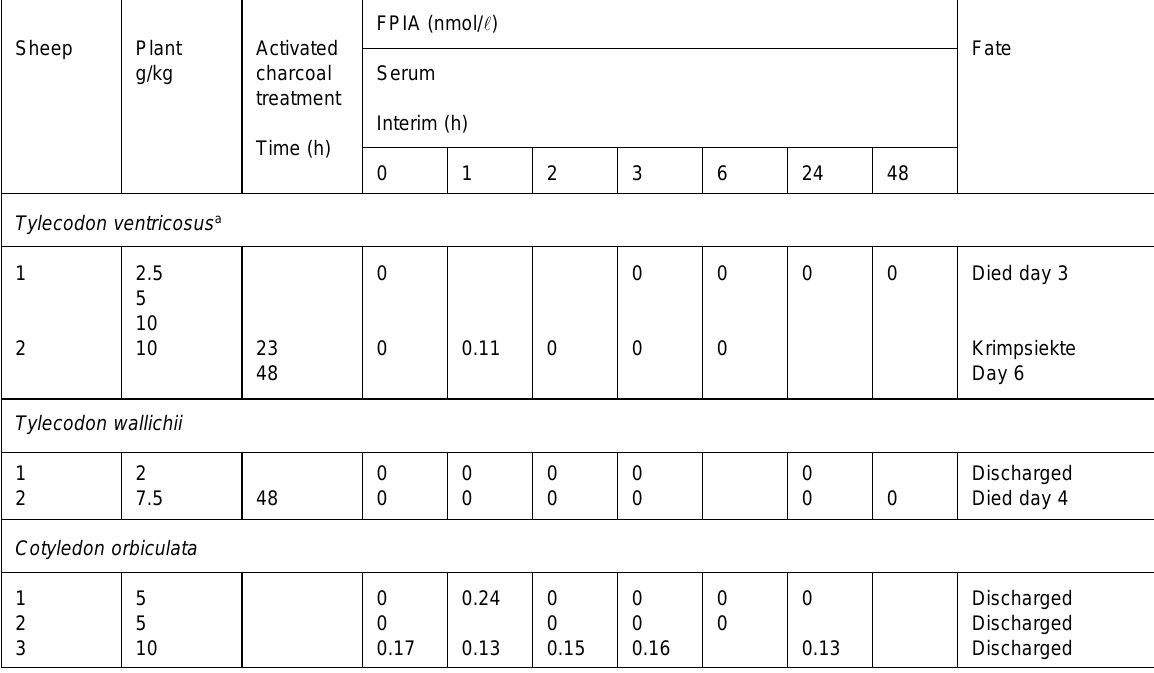
TABLE 8 FPIA values in sheep dosed with plakkies (fresh leaves and